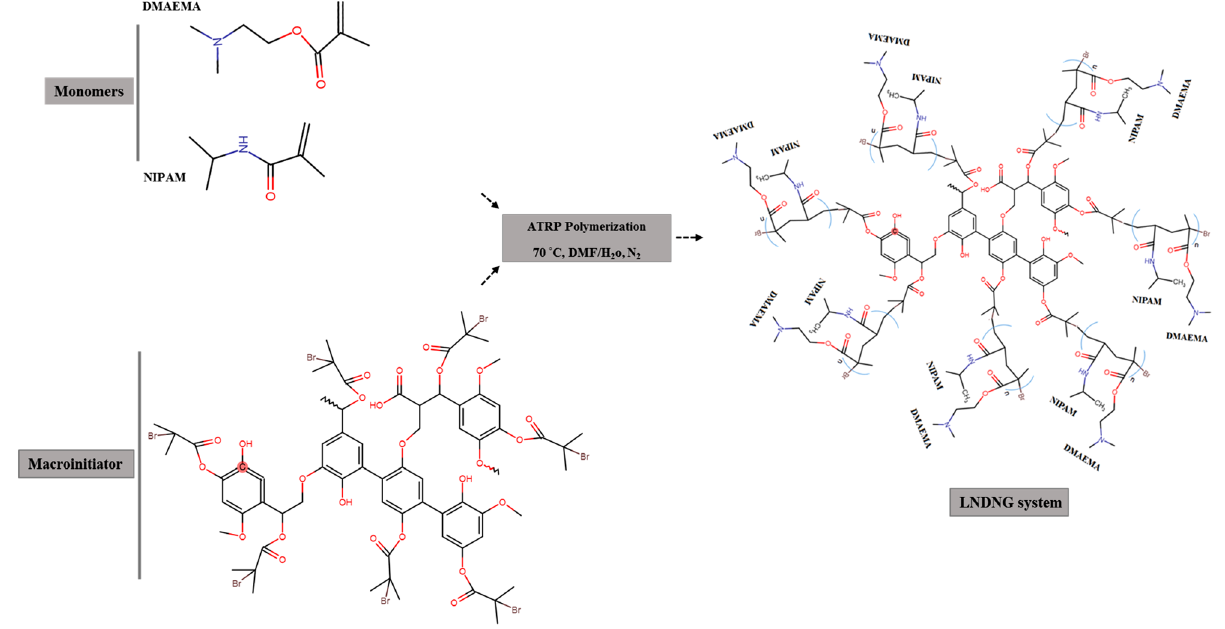
Figure 1. Schematic representation of fabrication procedure of lignin-g-P(NIPAM-co-DMAEMA) nanogel (LNDNG) via “grafting from” ATRP approach.